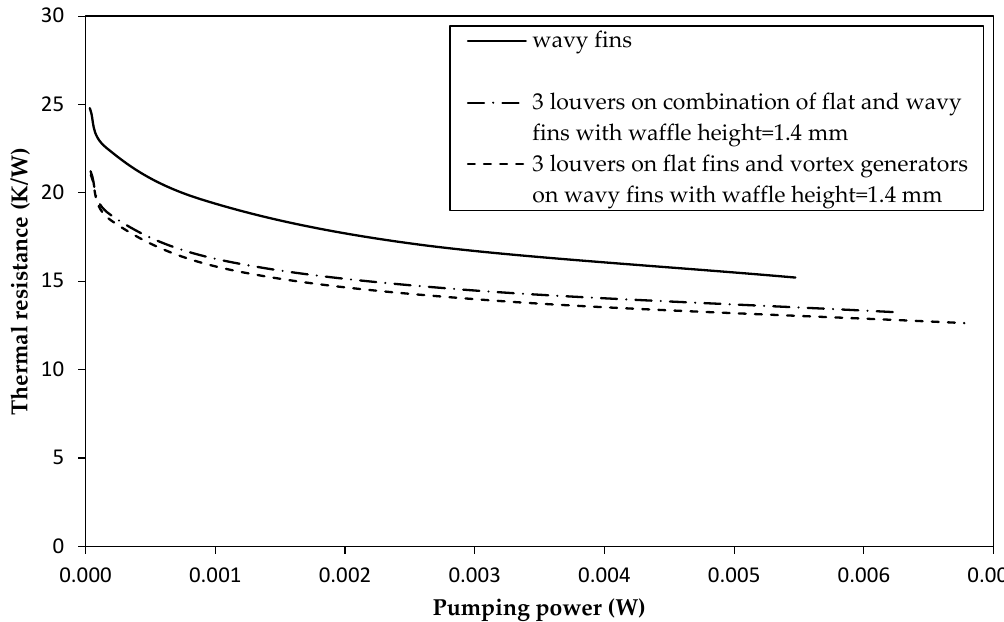
Figure 11. Thermal resistance vs. pumping power for comparison between wavy fins and compound geometry ( n = 3, W = 12 mm and θ = α = 13 ◦ ) with and without vortex generators. Comparison of temperature contours for the reference wavy fins and compound geometry with and without vortex generators for air inlet velocity of 2 m/s in the middle of fin pitch can be seen in